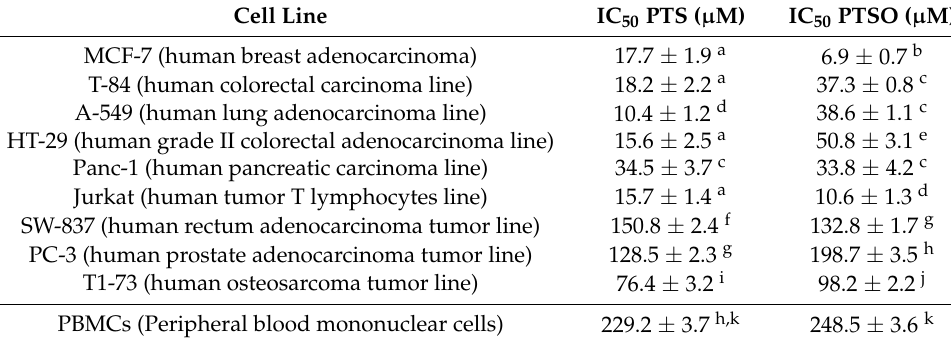
Table 1. Antiproliferative activity of PTS and PTSO against MCF-7, T-84, A-549, HT-29, Panc-1, Jurkat, SW-837, PC-3, T1-73, and PBMCs 72 h post-induction. Different letters differ significantly ( p <